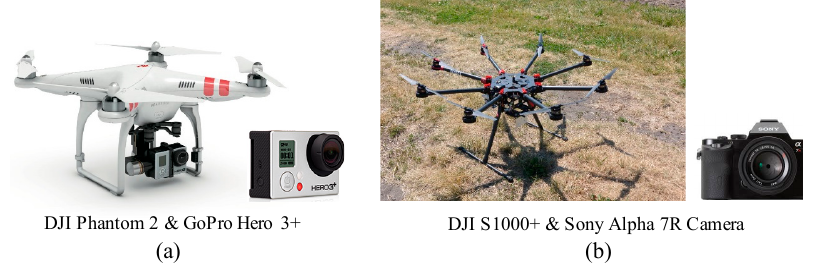
Figure 11. ( a ) The DJI Phantom 2 UAV with a GoPro Hero 3+ camera mounted on a gimbal, and ( b ) the DJI S1000+ UAV equipped with a Sony Alpha 7R camera with a vertical view. Table 1. Specification of the utilized UAV and cameras.